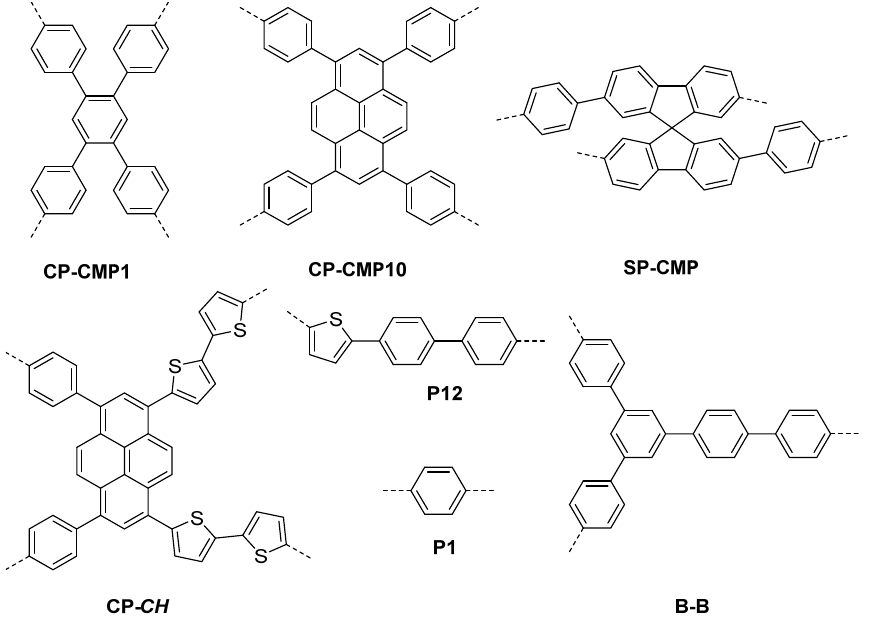
Figure 5. Examples of apolar polymer photocatalysts